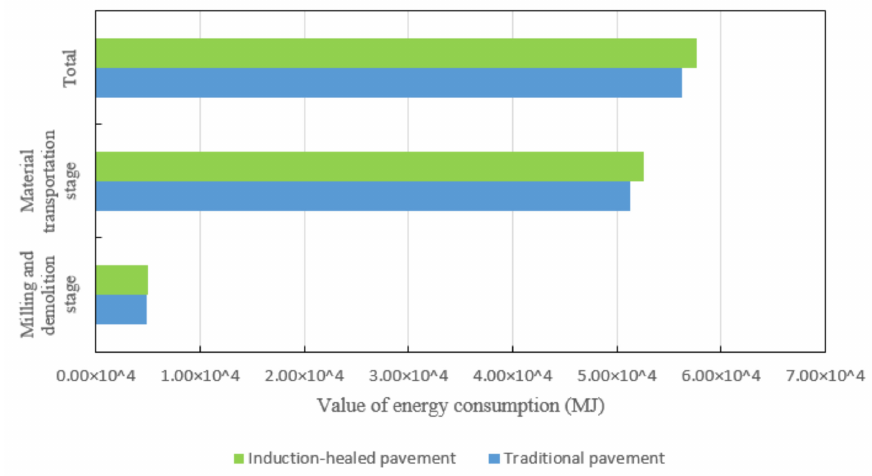
Figure 7. Energy consumption comparison of two asphalt pavements’ milling and demolition stages.